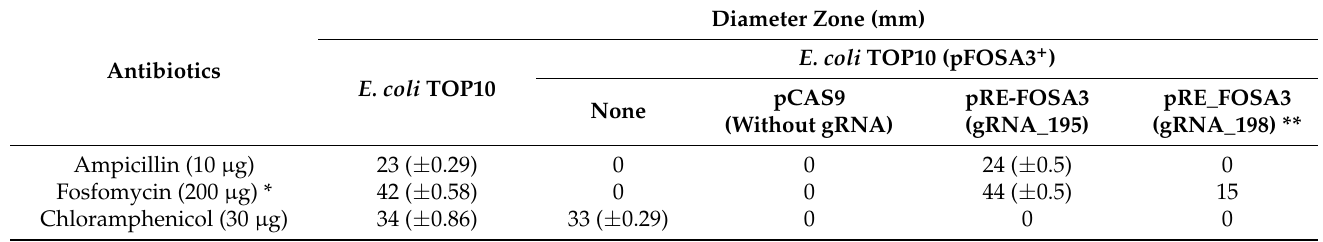
Table 1. Inhibition-zone diameters for ampicillin, fosfomycin, and